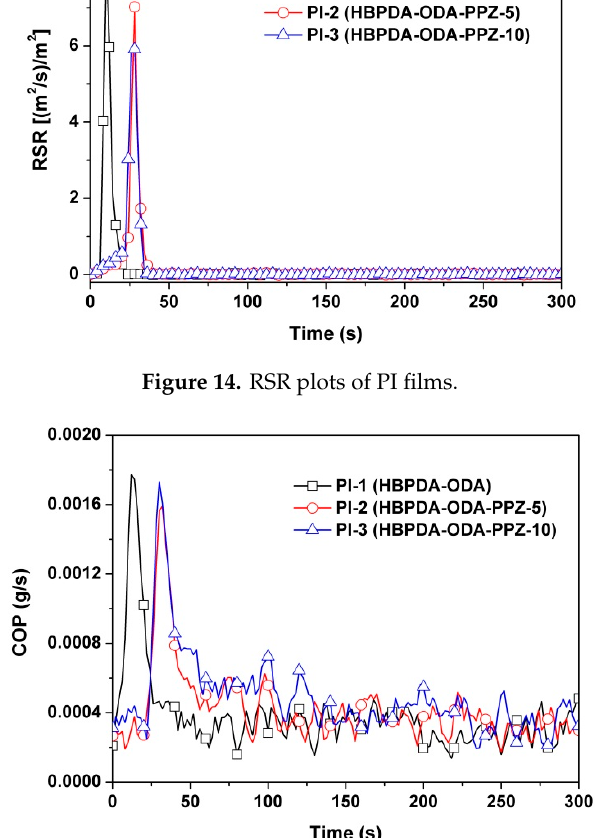
Figure 15. COP plots of PI films.